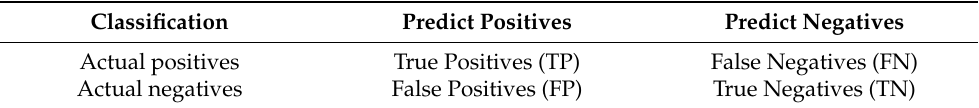
Table 2. Confusion